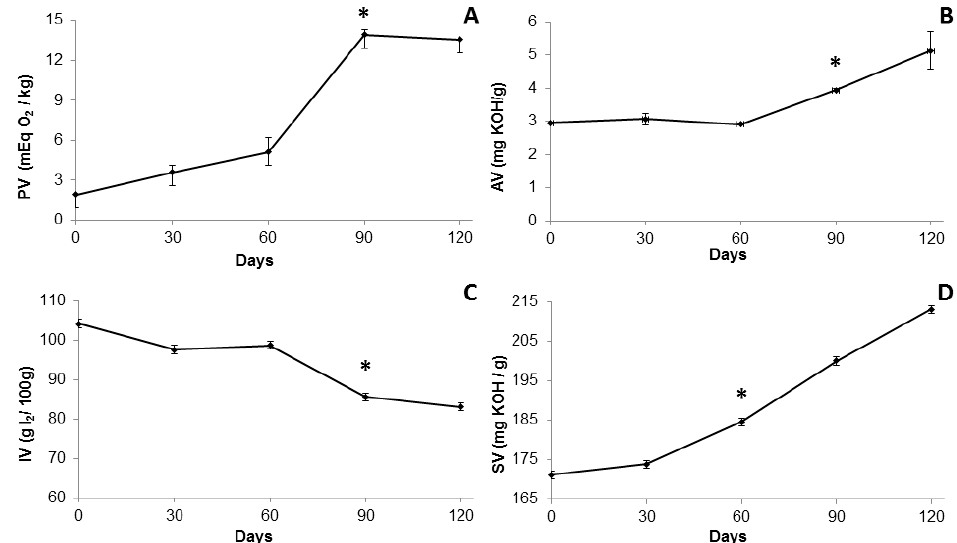
Figure 1. Physicochemical properties of the BO stored at room temperature over 120 days. ( A ) Peroxide value; ( B ) Acid value; ( C ) Iodine value; ( D ) Saponification value. * p ˂ 0.05.